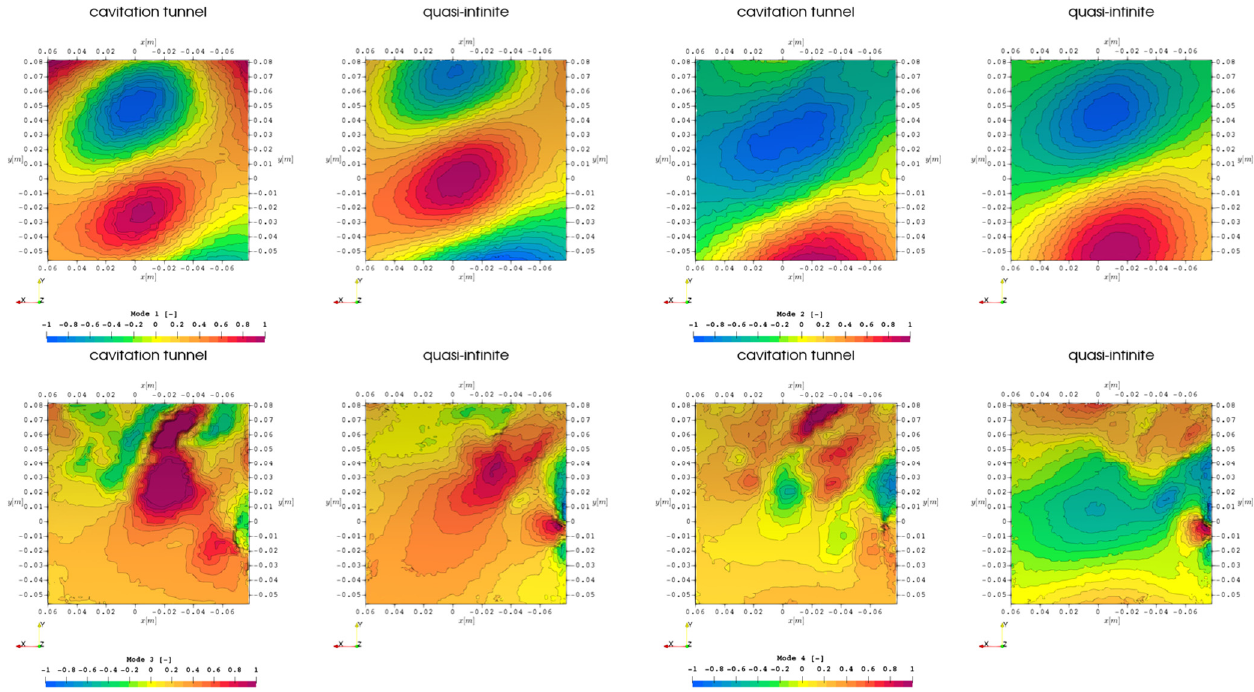
Figure 11. First 4 POD modes of pressure time data set on hull above propeller, comparison of domain extent, RANS with cavitation.